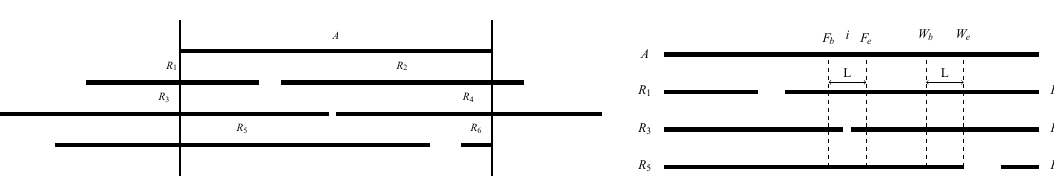
Figure 2. Left: An alignment pile for a template read A . The pile is delimited by vertical lines at the extremities of A . Prefixes and suffixes of reads overlapping A outside of the pile are not considered during the next steps, as the data they contain will not be useful for correcting A . Right: When fixing the length to L and the minimum coverage threshold to 3, the window ( W b , W e ) will be processed by CONSENT. With these same parameters, the window ( F b , F e ) will not be processed by CONSENT, as A [ i ] is not supported by at least 3 reads ∀ F b ≤ i ≤ F e